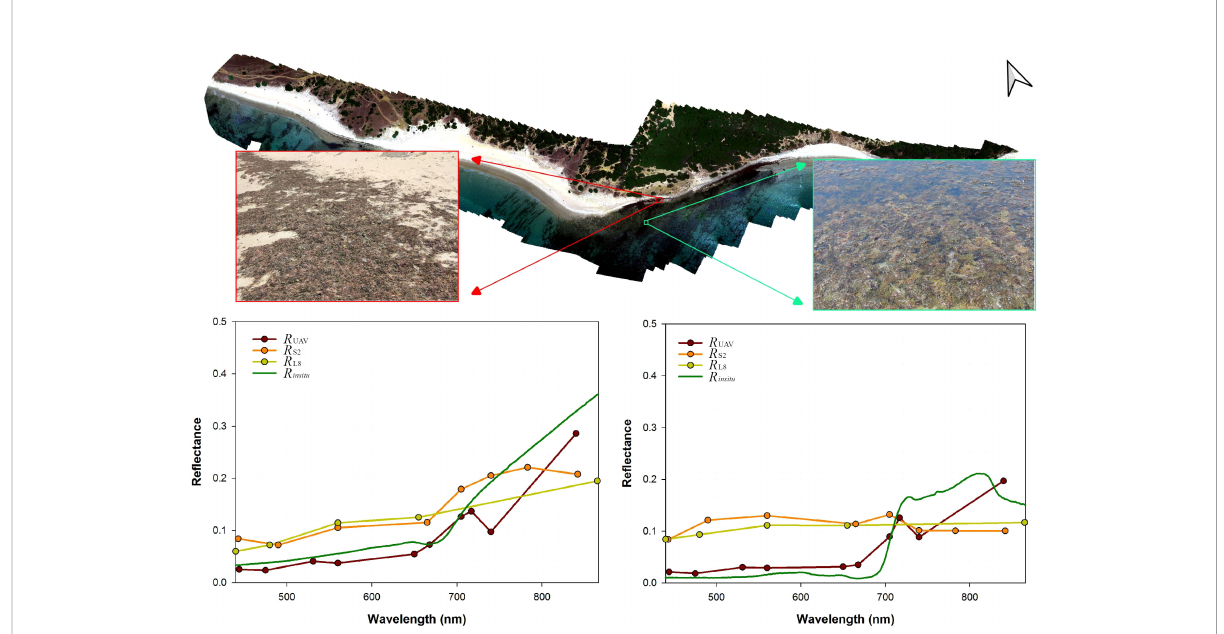
FIGURE 6 Spectral signatures for R. okamurae in the beaching zone (left) and submerged zone (right) for the different sensors ( in situ hyperspectral, UAV, S2 and